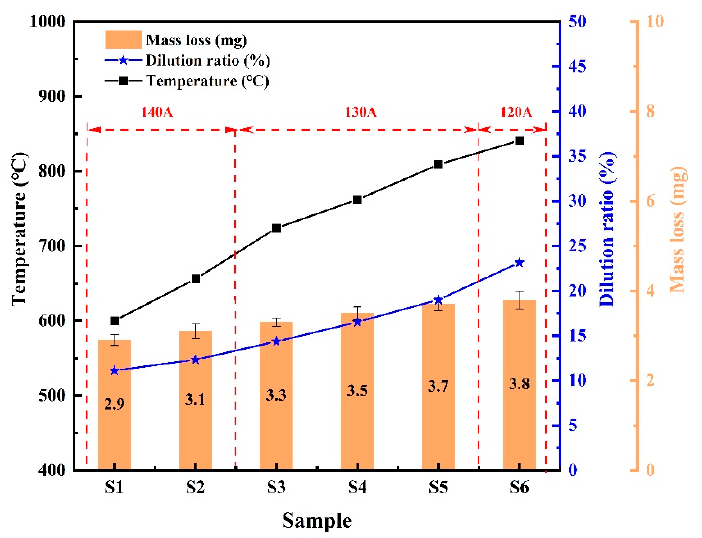
Figure 15. Diagram of the relationship between cladding temperature, dilution ratio and mass loss after adjusting the cladding current in stages.